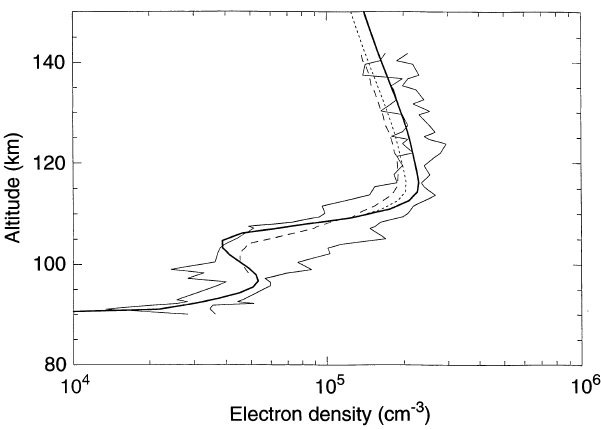
Fig. 2. The two thin solid lines show the maximum and minimum electron densities measured by the EISCAT radar above Tromsø on December 5, 1994, during the overpass of the DMSP spacecraft. The dashed line is from the computation of the electron density by Anderson et al . (1997). The dotted line and the thick solid line are from our present computation with an attenuation factor for spreading of 0.75 and